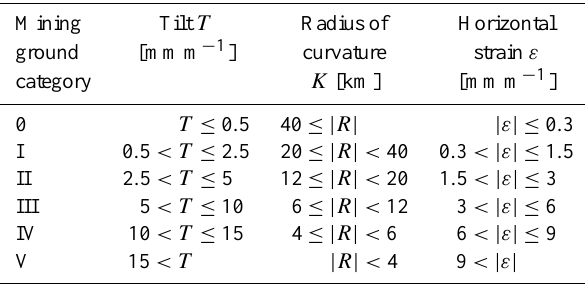
Table 2. Risk classification of mining grounds (after Popiolek,